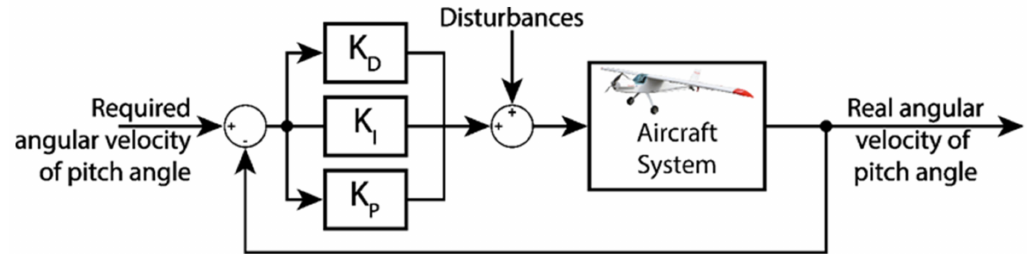
Figure 5. Block diagram of PID